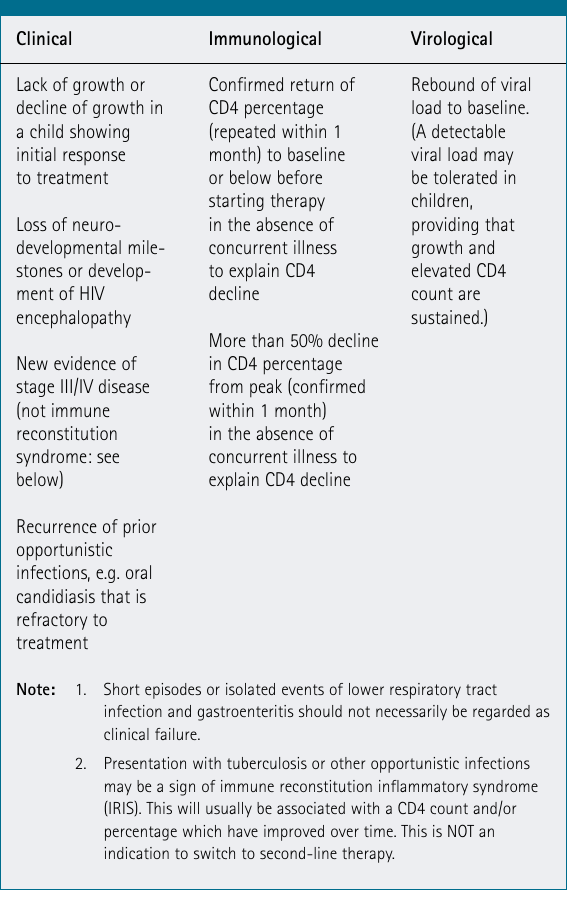
TABLE III. REASONS TO MOVE TO SECOND-LINE ARV THERAPY IN